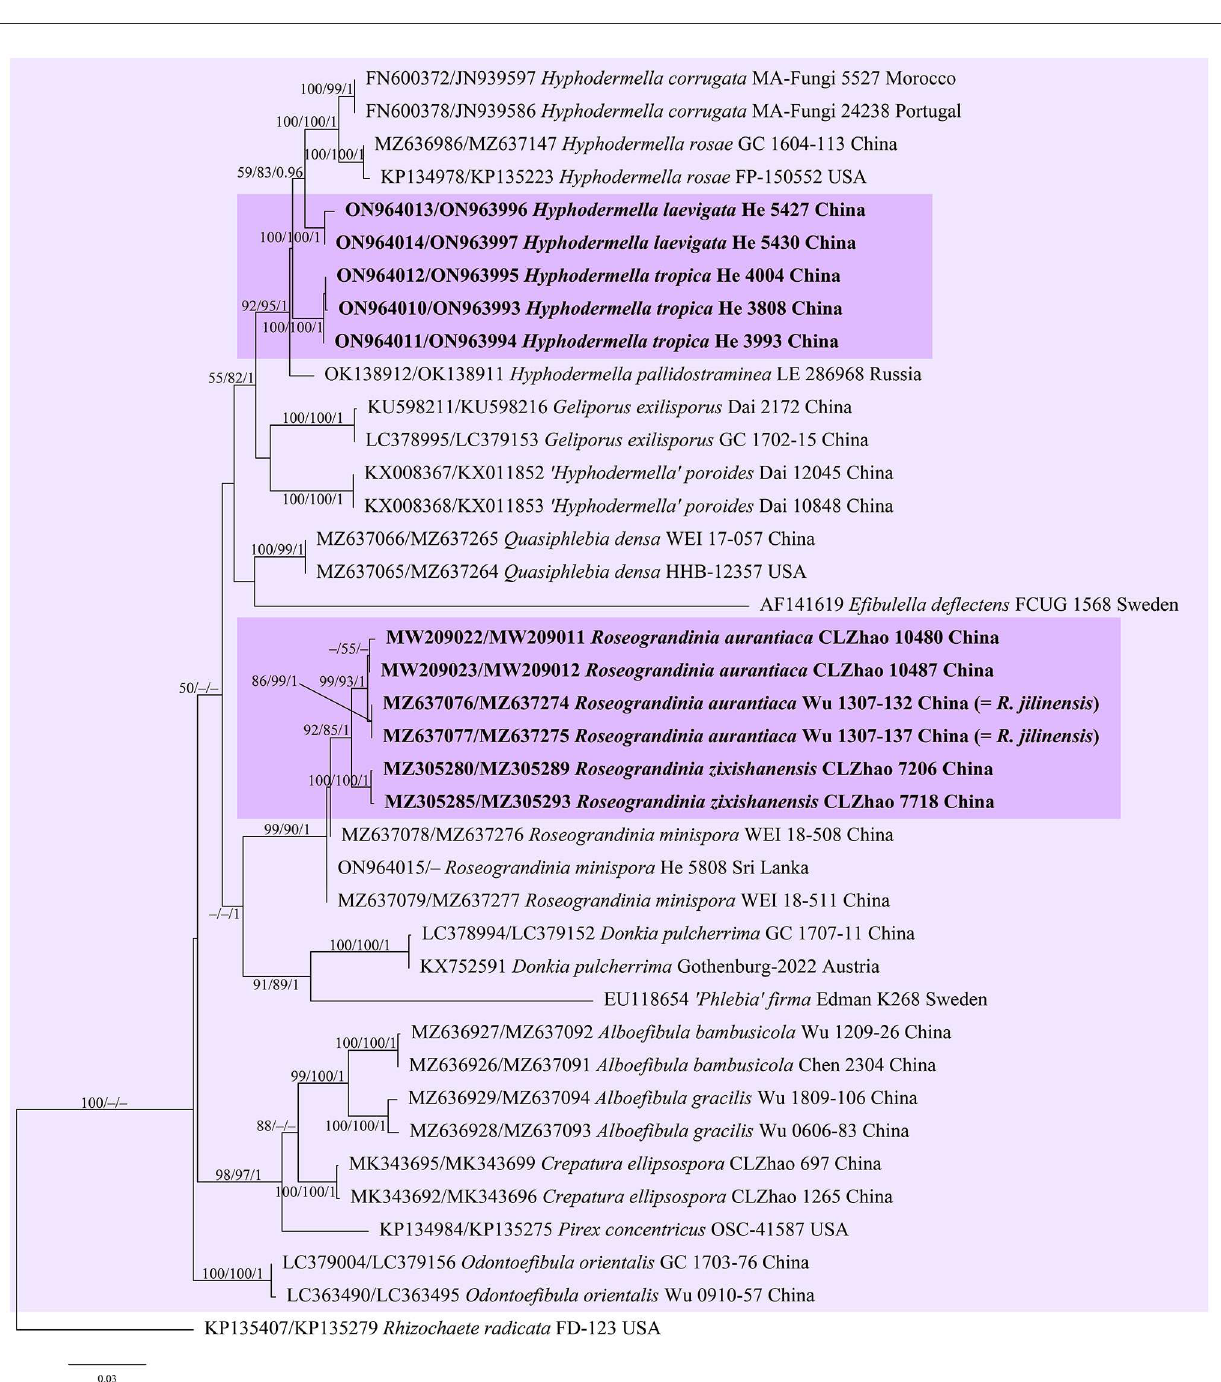
(TBR) branch-swapping algorithm with all characters given equal weight. Branch supports for all parsimony analyses were estimated by performing 1,000 bootstrap replicates with a heuristic search of 10 random-addition replicates for each bootstrap replicate. In ML analysis, statistical support values were obtained using rapid bootstrapping with 1,000 replicates, with default settings for other parameters. For BI, the best-fit substitution model was estimated